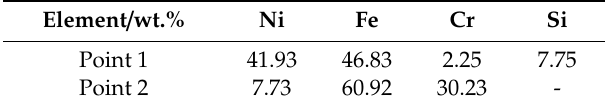
Table 5. EDS point analysis of the annealed coating at 990 °C coating.